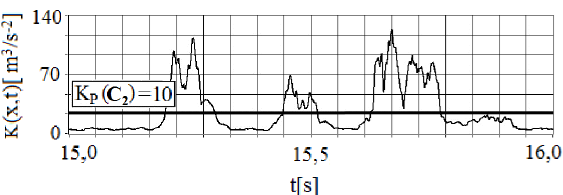
Fig. 5 . Criterion function K (t) with threshold value K P (C 2 )=10 .